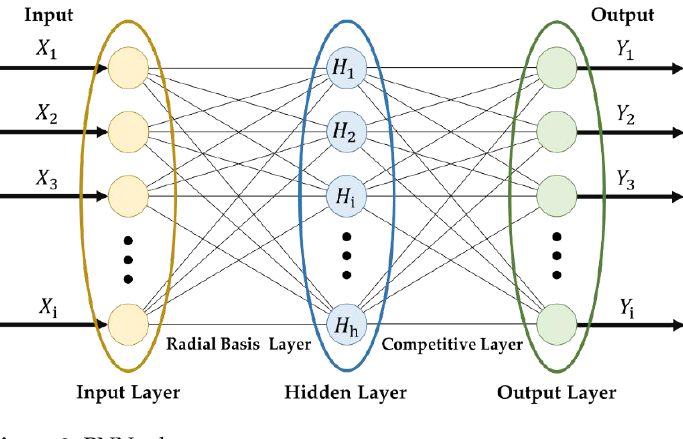
Figure 2. PNN scheme.